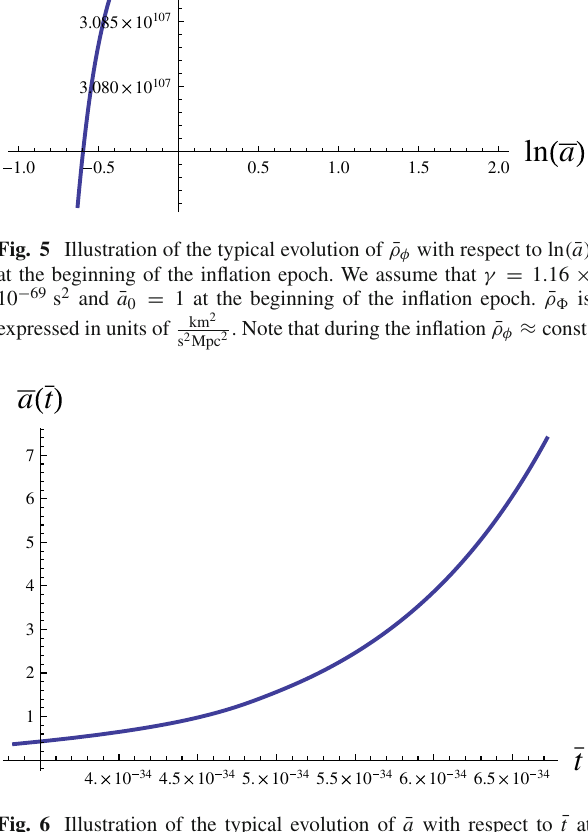
Fig. 6 Illustration of the typical evolution of ¯ a with respect to ¯ t at the beginning of the inflation epoch. We assume that γ = 1 . 16 × 10 − 69 s 2 and ¯ a 0 = 1 at the beginning of the inflation epoch. The time ¯